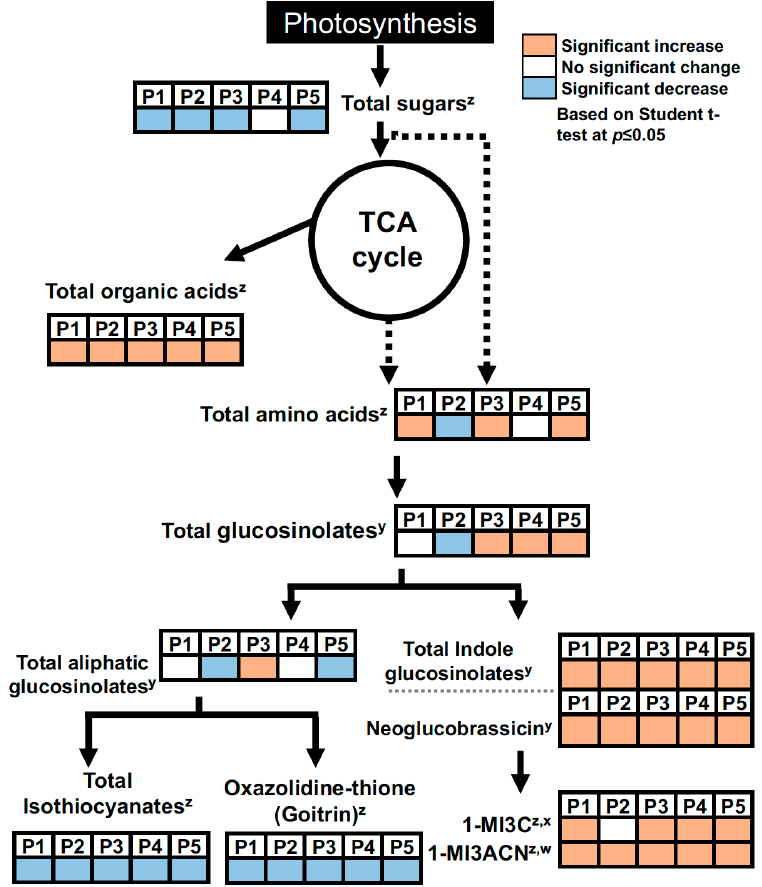
Figure 4. Summary of MeJA effect on primary and secondary metabolites. All data were compared to control by Student’s t -test at p ≤ 0.05. GS, glucosinolate; 1-MI3C, 1-methoxyindole-3-carbinol. P1, “Baby bok choy”; P2, “Chinese cabbage”; P3, ”Asian“; P4, “Col baby choi”; P5, “Pak choi pechay”; x 1-methoxyindole-3-carbinol; y based on compound concentration; w 1-methoxyindole-3-acetonitrile; z Based on peak intensity. The dotted line indicates the conversion is simplified biosynthesis without